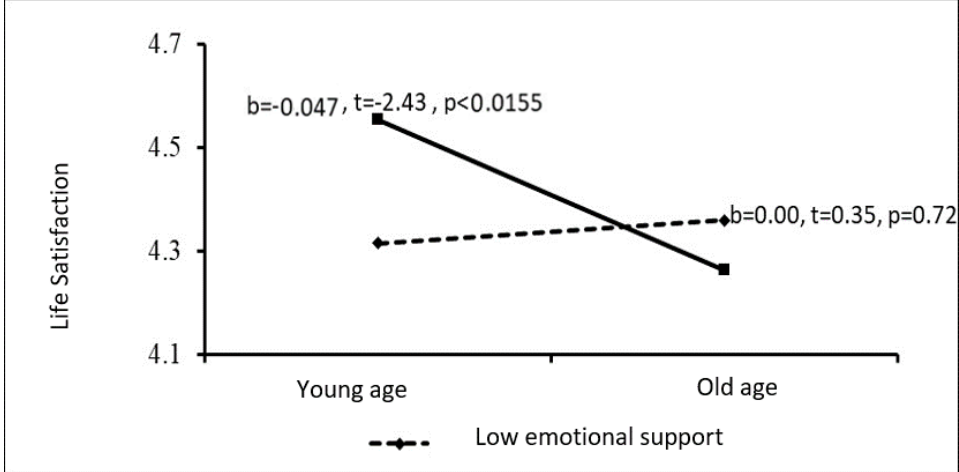
Figure 1. Emotional parental support as a moderating variable between age and life satisfaction.